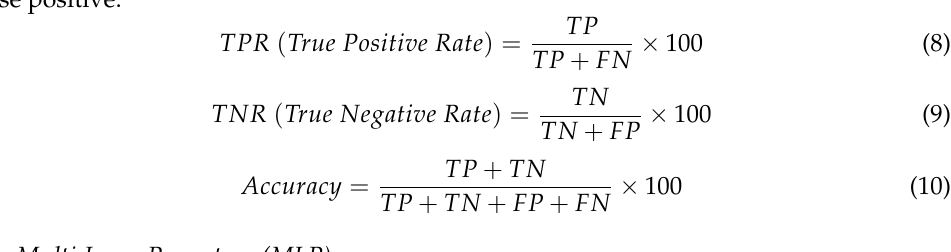
Table 8. Hyper parameter settings for the one-class SVM-based anomaly detection models.